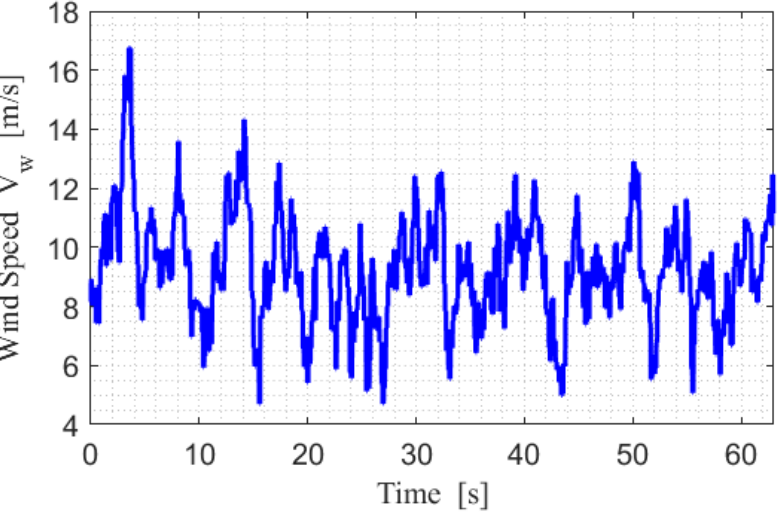
Figure 11. Changes in wind speed with time during the